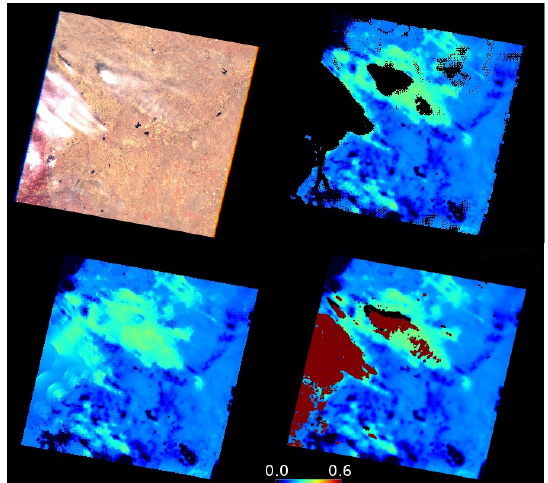
Figure 7. Successive steps used to fill the gaps in an AOT image. Top Left, a TOA LandSat Image acquired for Boulder; top right, the AOT estimated by the multi-sensor atmospheric correction and cloud screening (MACCS) hybrid method with the gaps in black; bottom left, the same image gap filled; bottom right, the AOT image gap filled and smoothed, with the cloud mask overlayed in red and the shadows mask in